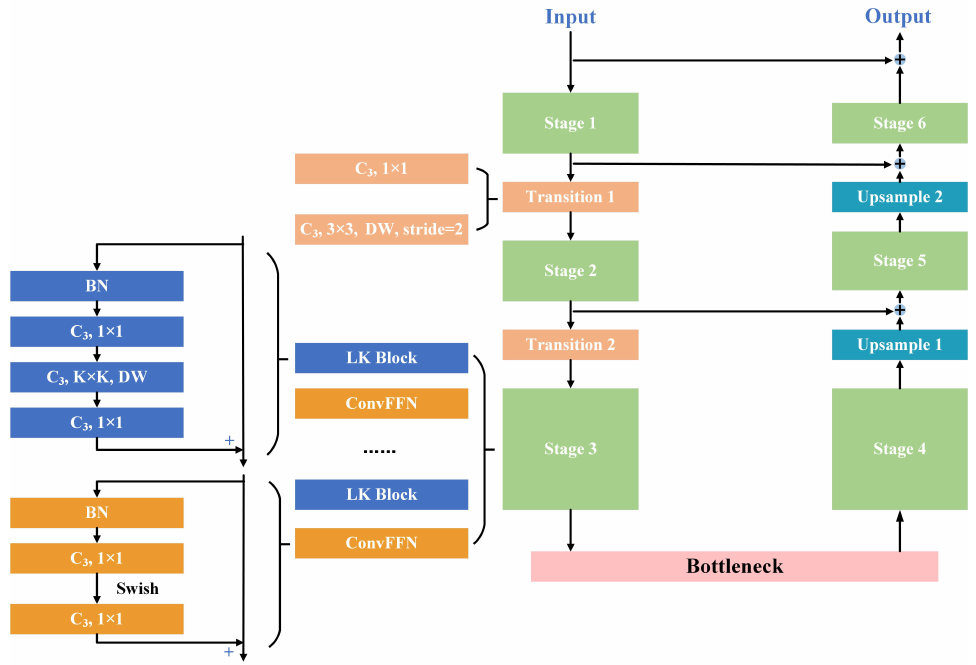
Figure 3. The architecture of Head 1 and Head 2 . Each stage contains several LK blocks, and the DW convolution in each LK block uses a 5 × 5 kernel for re-parameterization.